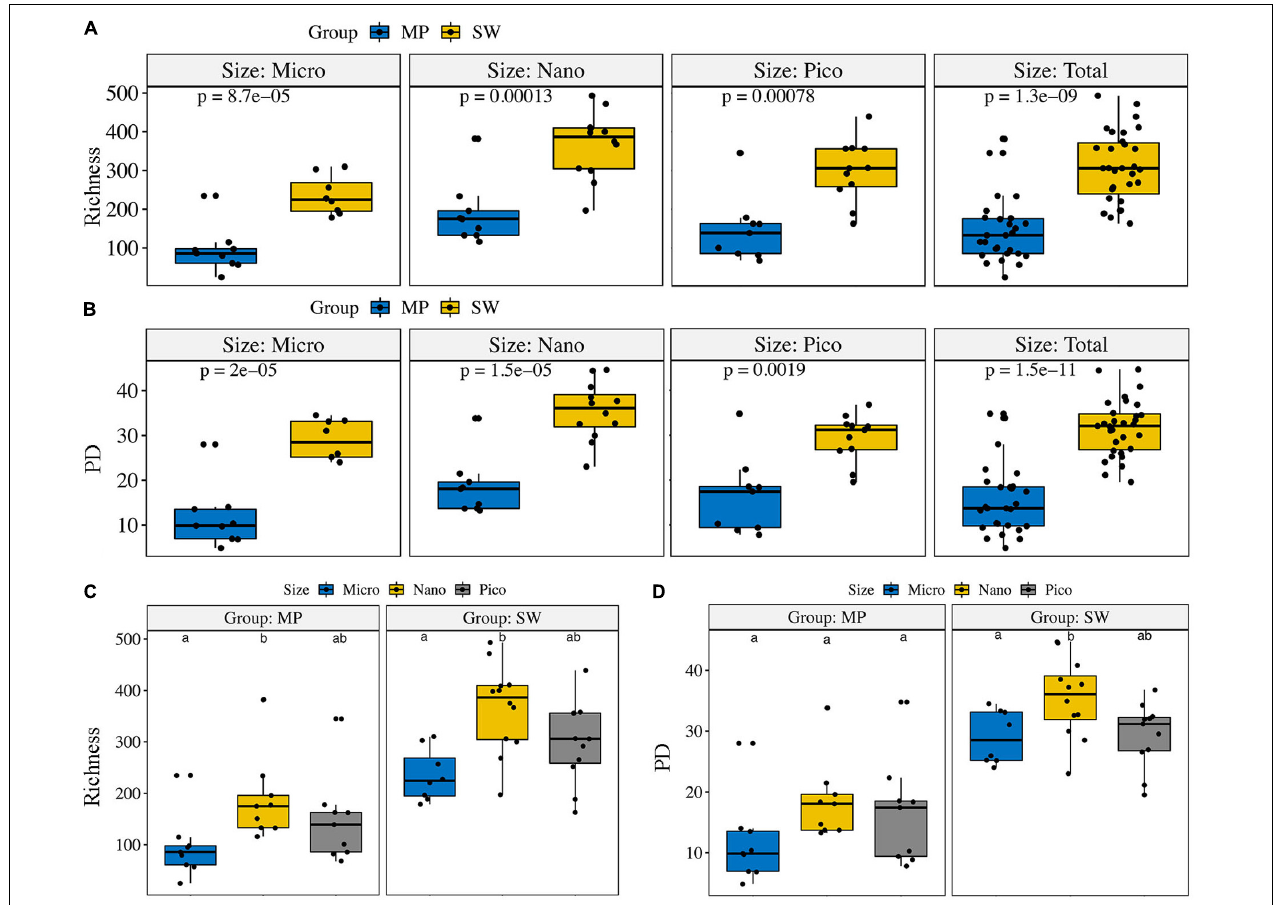
FIGURE 3 | Alpha-diversity estimates (Richness and PD) for the size-fractionated (A,B) samples of the melt ponds (MPs) and sea water (SW) and for the pooled (C,D) MP and SW samples, respectively. The line in each box plot indicates the median, the box delimits the 25th and 75th percentile. Bars in (C,D) without shared letters indicate significant differences at the level of p = 0.05.